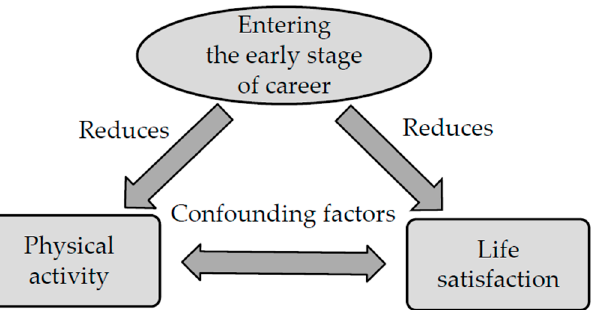
Figure 1. The confounded causality due to the self-selection bias (endogeneity) of “being physi- cally